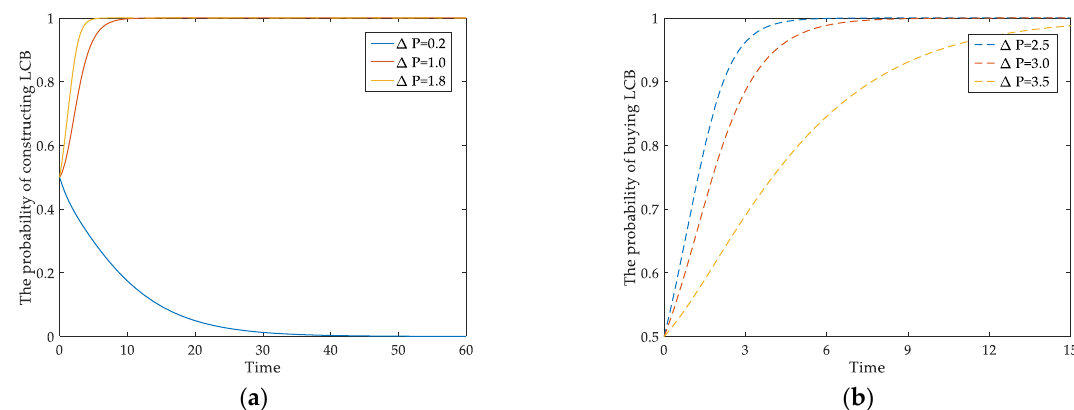
Figure 3. The impact of ∆ P on ( a ) developer’ behavioral evolution; ( b ) homebuyers’ behavioral evolution.